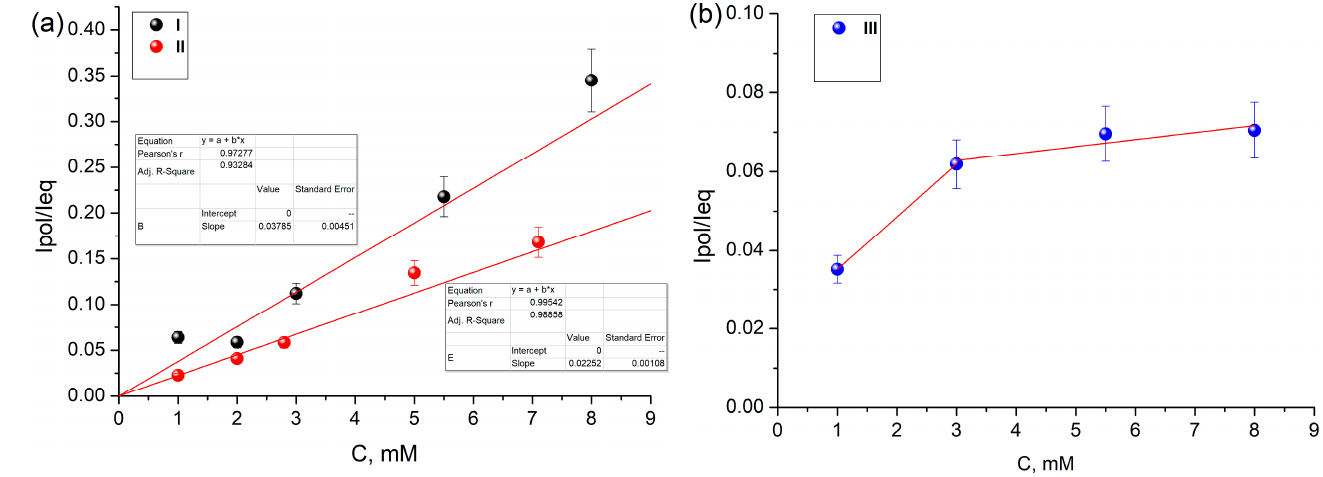
Figure 5. Concentration dependencies of the CIDNP effects for I , II ( a ) and III ( b )